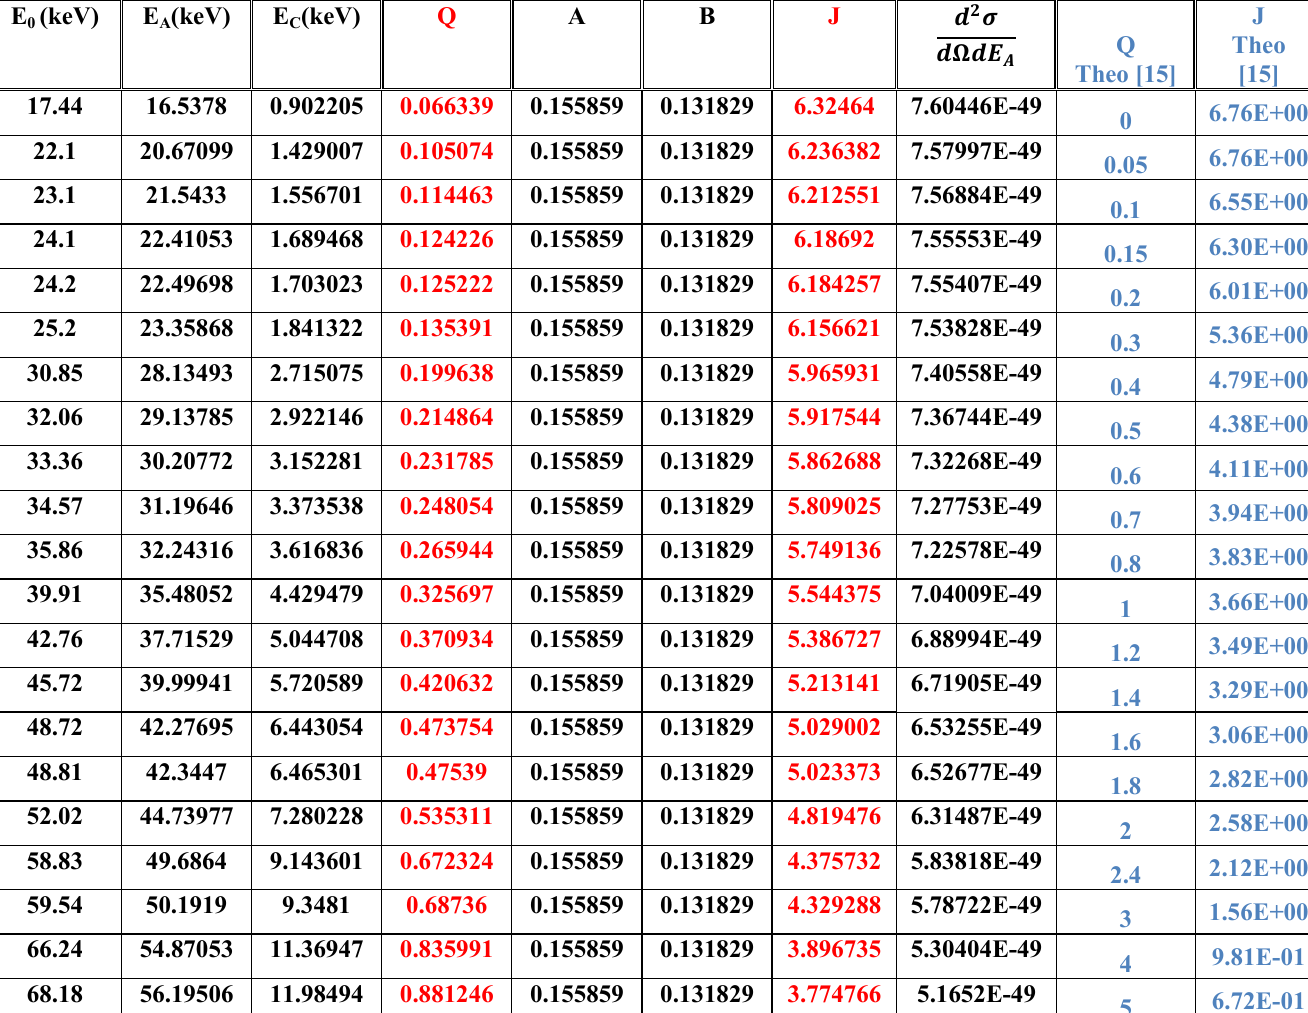
Table 1: Compton profile and double-differential scattering cross section of doppler broadening for ( 26